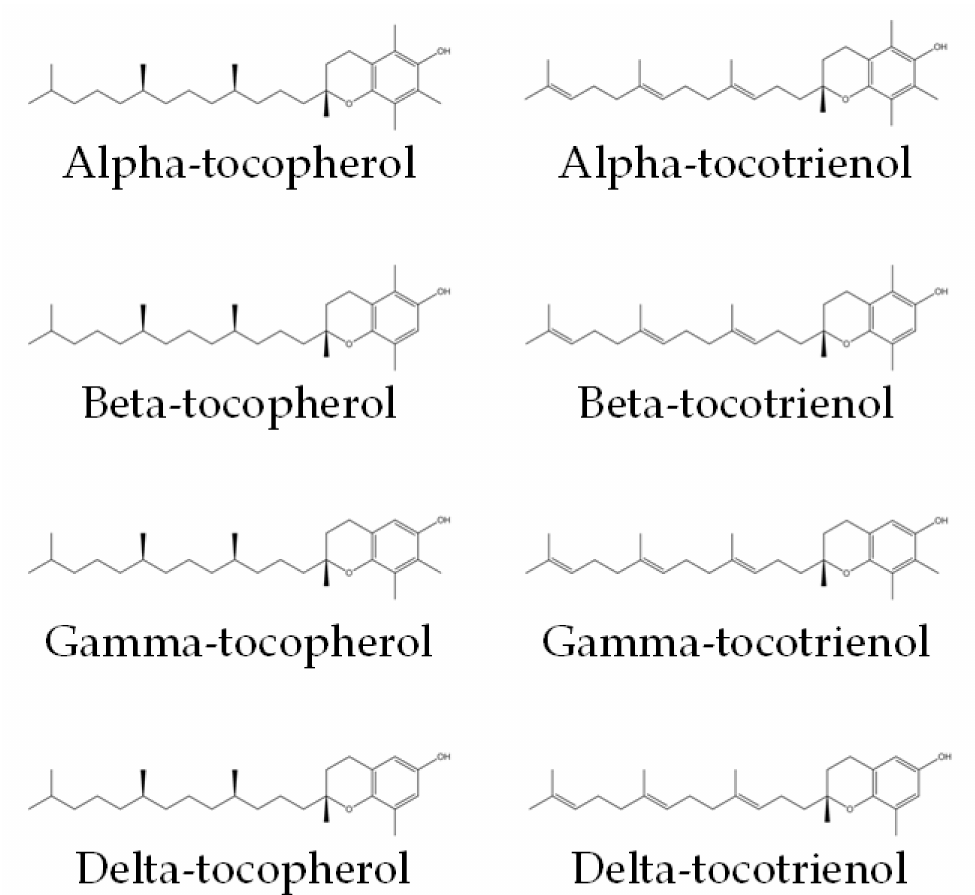
Figure 1. Chemical structures of tocopherols and tocotrienols [22]. They consist of a chromanol ring and a long carbon tail. On the carbon tail, tocotrienols have three double bonds, whereas tocopherols have only single